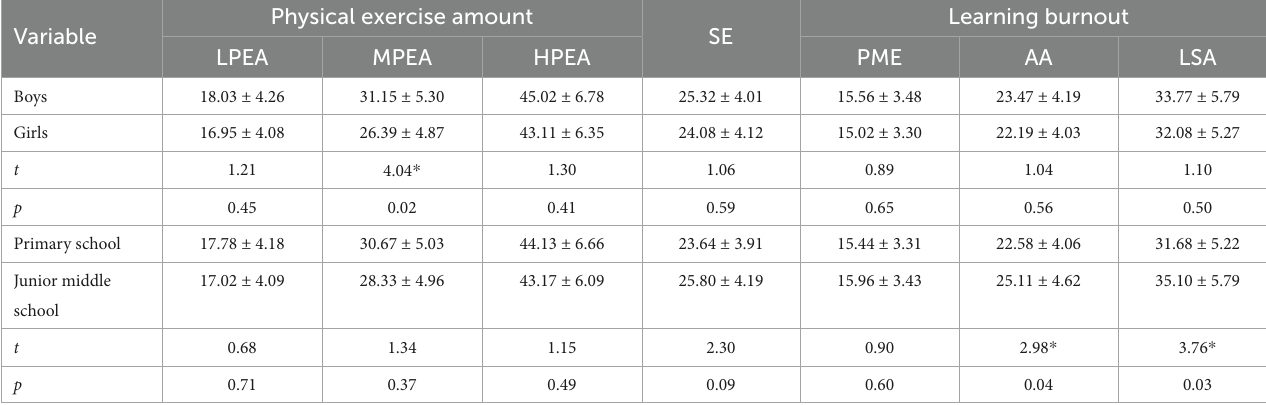
TABLE 2 Differences in the physical exercise amount, self-efficacy, and learning burnout among adolescents.